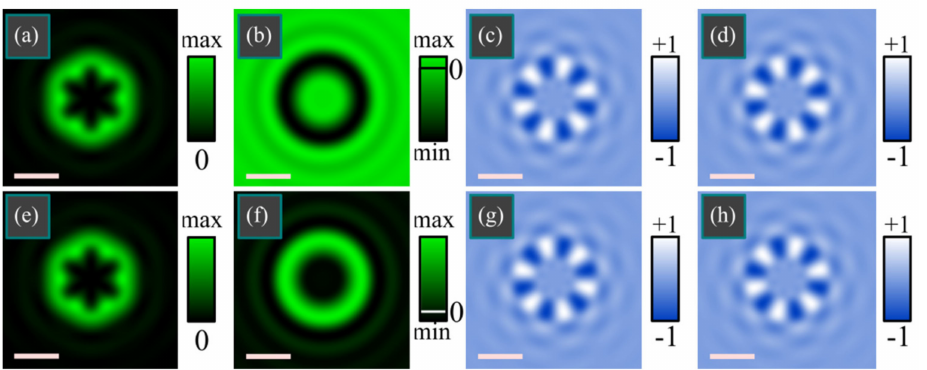
Figure 4. Distributions of intensity ( a , e ), radial component of the Poynting vector ( b , f ), normalized- to-maximum longitudinal component of the SAM vector ( c , g ), and normalized-to-maximum lon- gitudinal component of the OAM vector ( d , h ) of a sharply focused Gaussian beam with 4th-order cylindrical polarization before the focus ( a – d ) and beyond the focus ( e – h ). In all the figures, light and black colors mean, respectively, maximum and minimum. Scale marks (in the bottom left corner) denote 1 µ